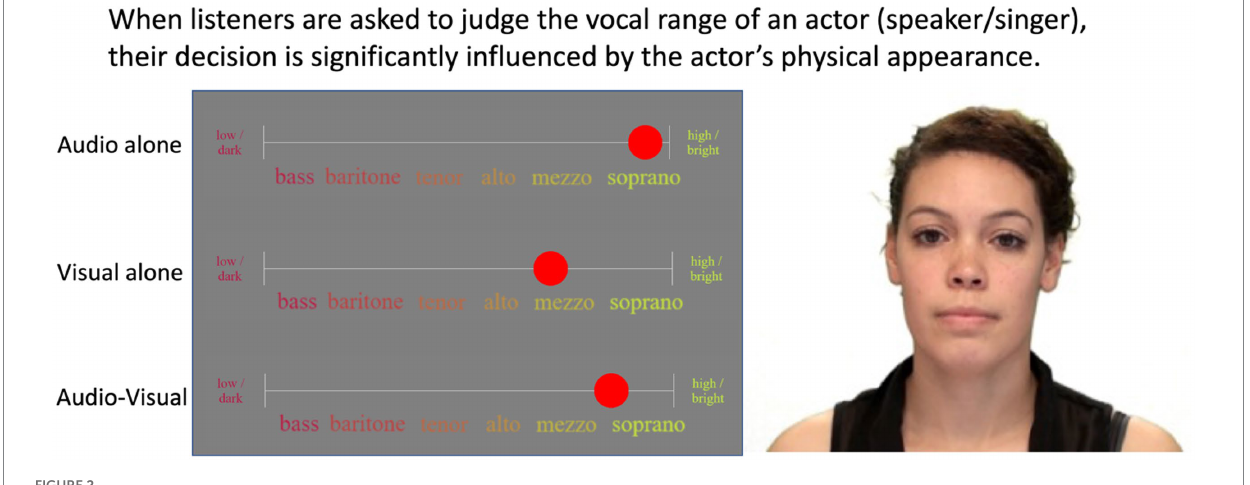
FIGURE 2 Design and interface showing a representative set of A/V/AV ratings for a single actor (not the task screen). Photo is available as part of the RAVDESS database and is reproduced with permission from Steven R. Livingstone and Frank A. Russo (Livingstone and Russo,